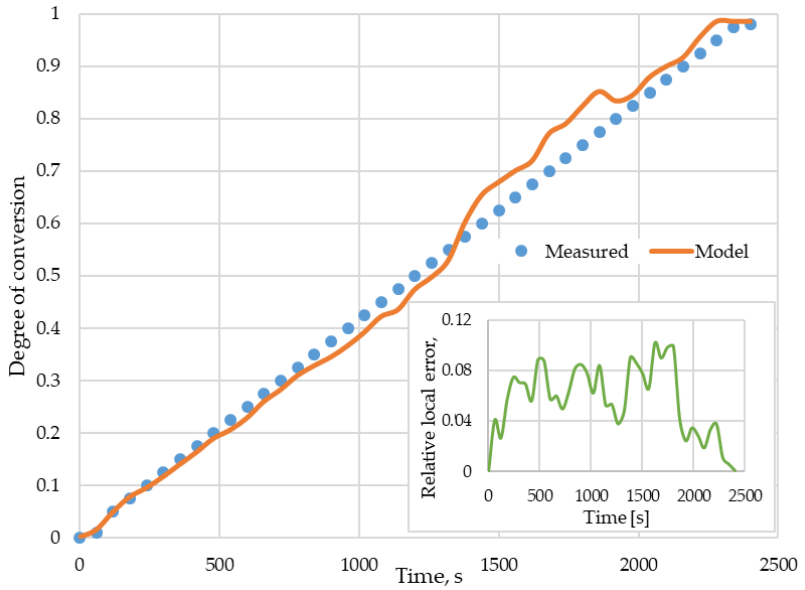
Figure 20. Comparison of the degree of conversion measured with the degree of conversion calculated.